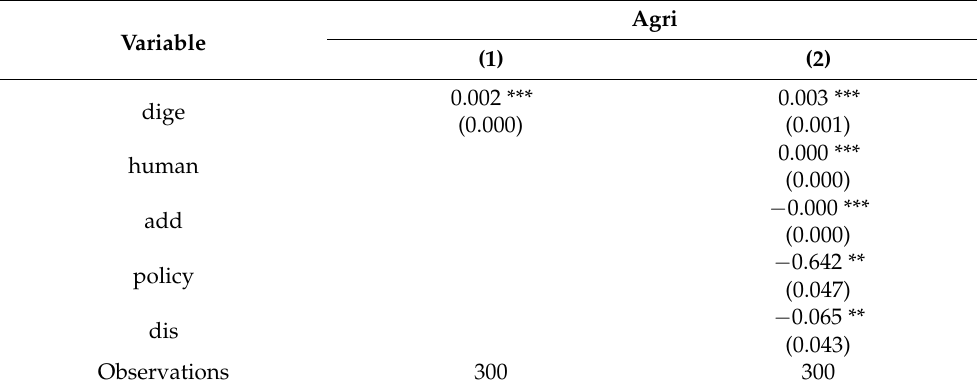
Table 5. Benchmark regression